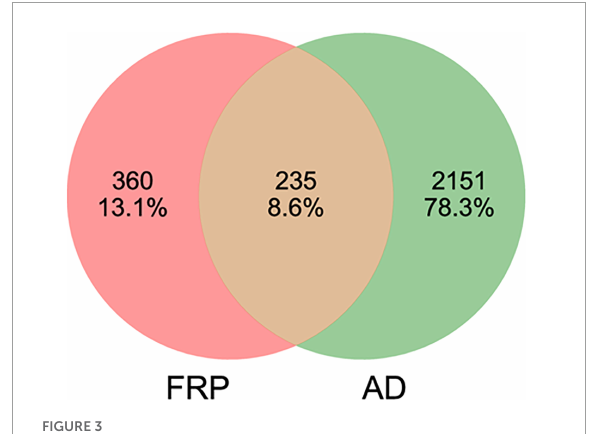
FIGURE3 The intersection of FRP and AD targets.